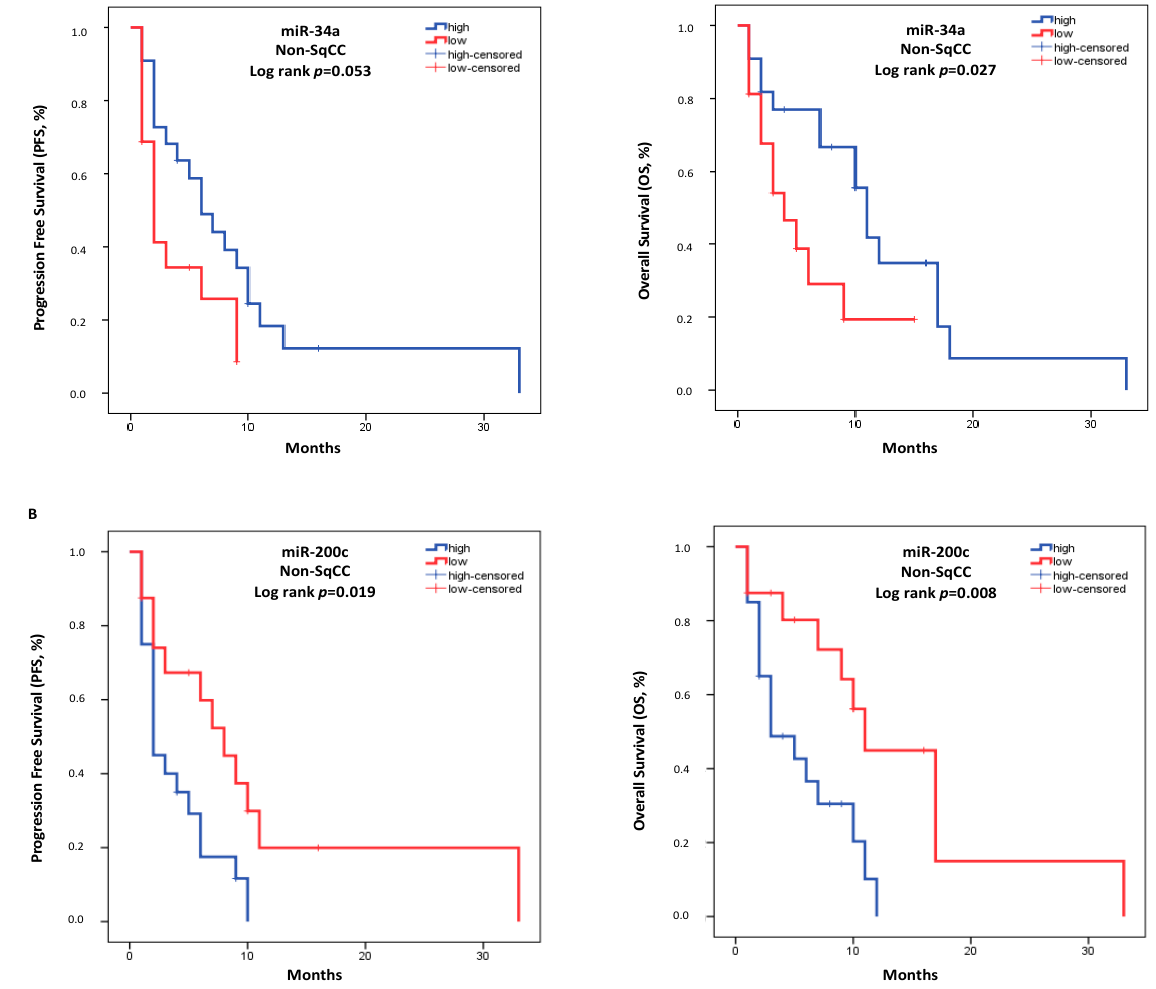
Figure 3. Kaplan–Meier analysis for PFS (Left) and OS (Right) based on the miR-34a ( A ) and miR-200c ( B ) expression levels in the plasma of patients with non-SqCC subtype (N = 38). Median expression values classified patients into high and low expression groups. Curves were compared using the log-rank test. p- values are shown.